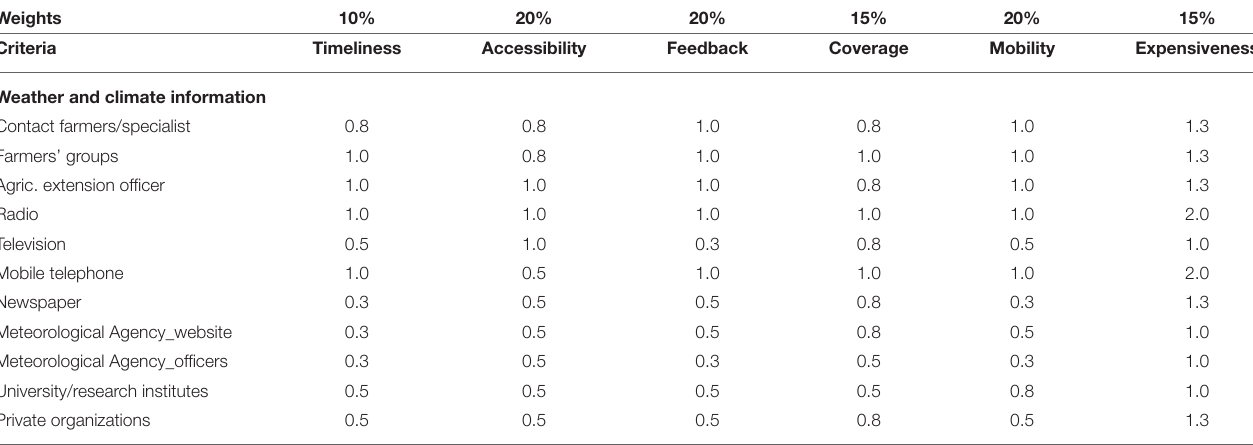
TABLE 14 | Estimates of normalized decision matrix a and relative significances of criteria (criteria weights) (Delivery